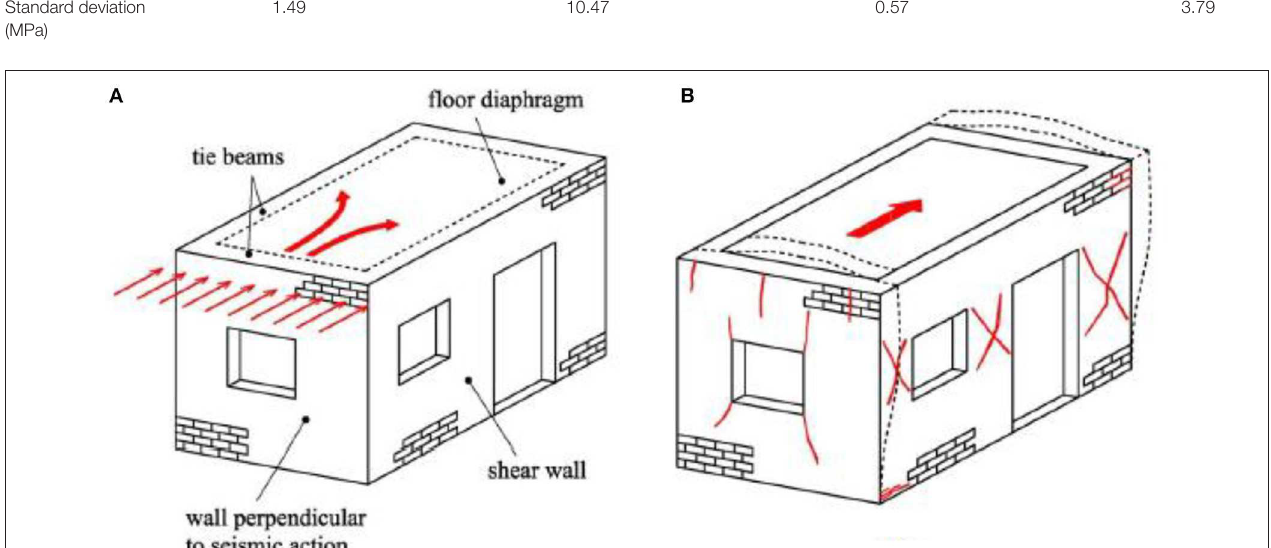
FIGURE 4 | (A) Flow of forces in an unreinforced masonry building with rigid diaphragm. (B) Failure mechanisms to be considered when rigid diaphragm is absent (Tomaževiˇc, 1999; Reproduced with the permission of the authors).